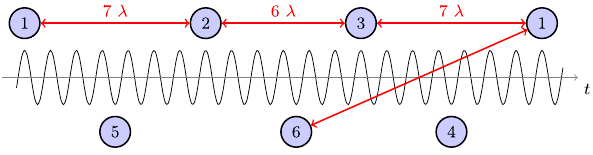
14. When the recirculation is in place, the linacs are populated with bunches at different turns (the turn number is